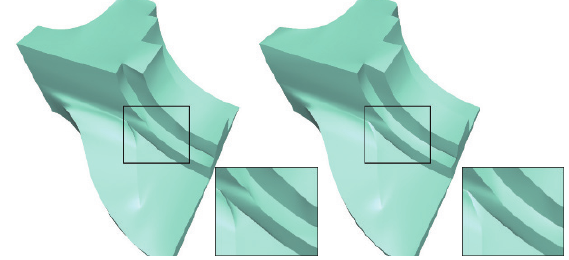
Fig. 5 Smoothing alternatives. Left: use of L 2 norm. Right: use of total Laplacian. Close-up views are shown at lower